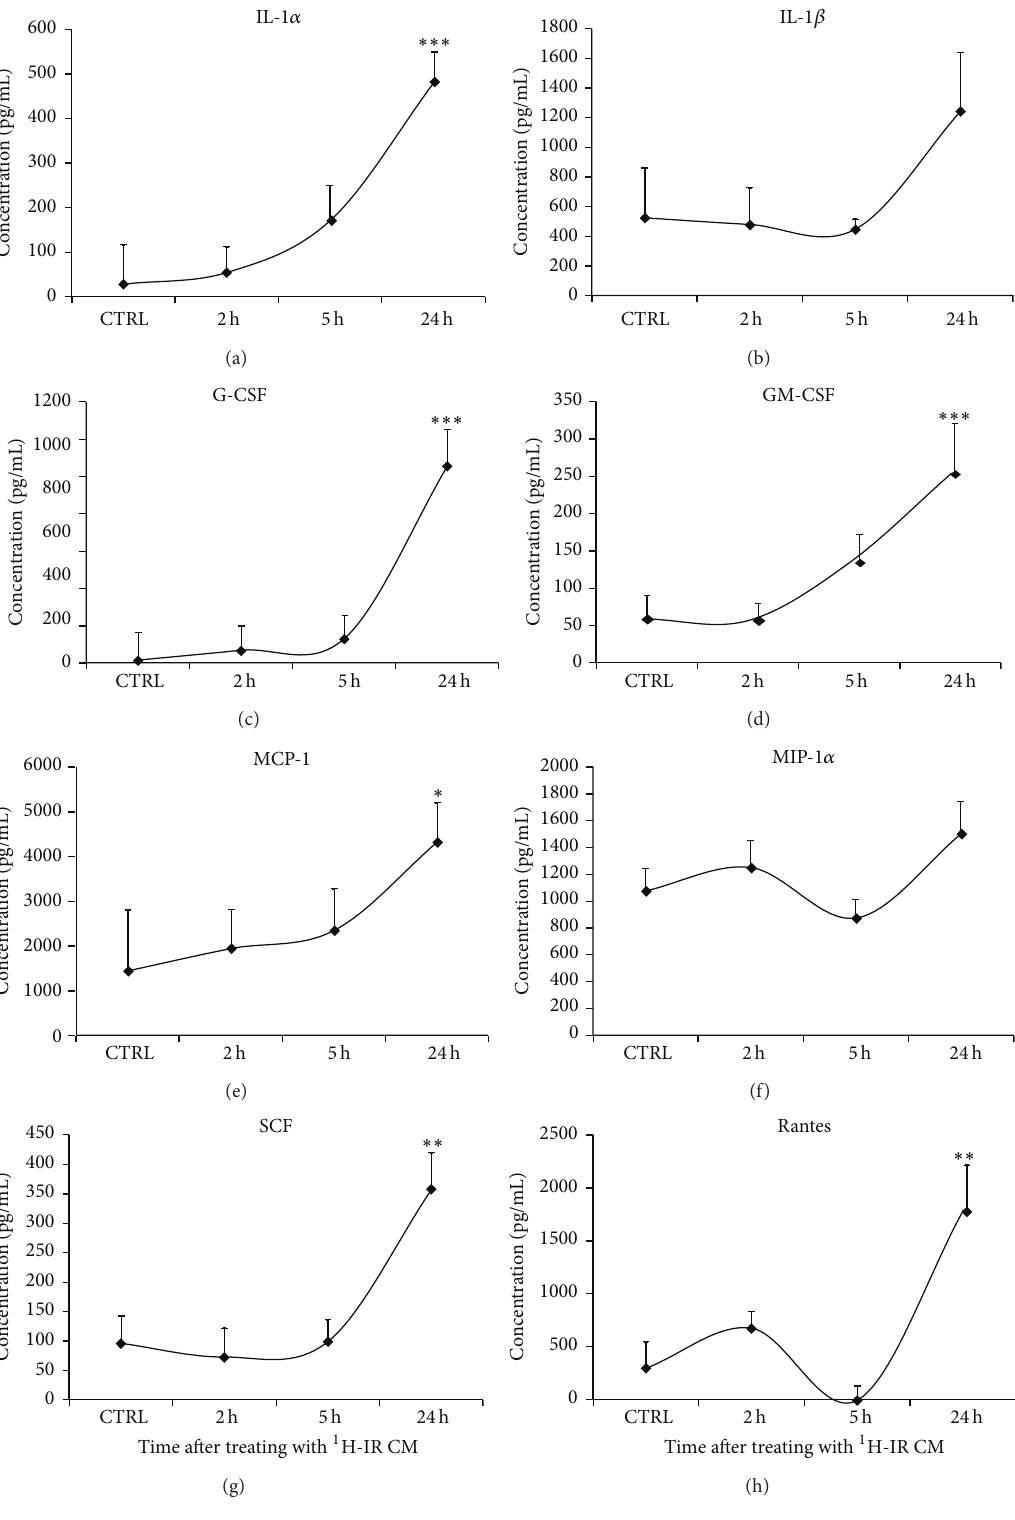
Figure 4: Cumulative levels of inflammatory cytokines and chemokines are significantly increased in 1 H-IR conditioned medium. Graphic representation of IR-induced increases in the cumulative concentration (pg/mL) of cytokines, chemokines, and growth factors in CM from 90 cGy 1 H-IR BM-EPCs in vitro at 2, 5, and 24 h after IR for (a) IL-1 𝛼 , (b) IL-1 𝛽 , (c) G-CSF, (d) GM-CSF, (e) MCP-1, (f) MIP-1 𝛼 , (g) SCF, and (h) Rantes. Graphs represent mean ± SEM of the pooled data from 3 independent biological samples/experiments. Statistical significance was assigned when 𝑃 < 0.05